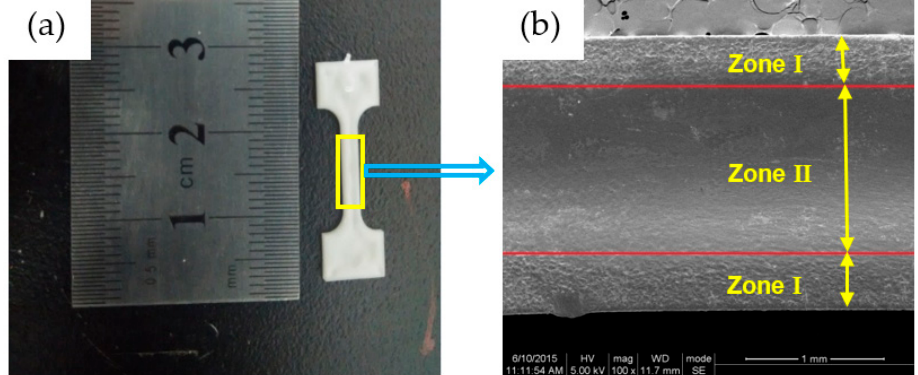
Figure 11. The digital photo ( a ) and SEM micrograph ( b ) of μ -PLA/PCL-26 micropart.